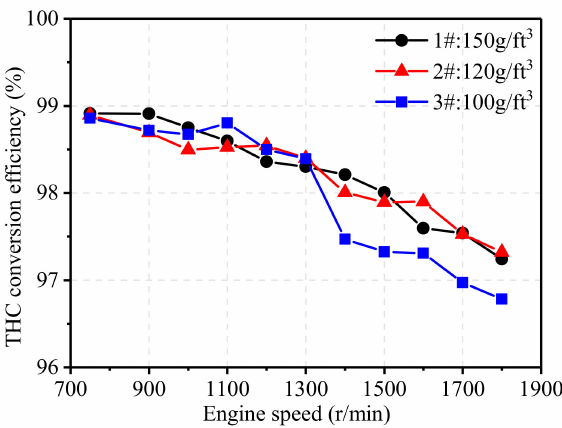
Figure 12. E ff ect of noble metal loading on THC conversion e ffi ciency.